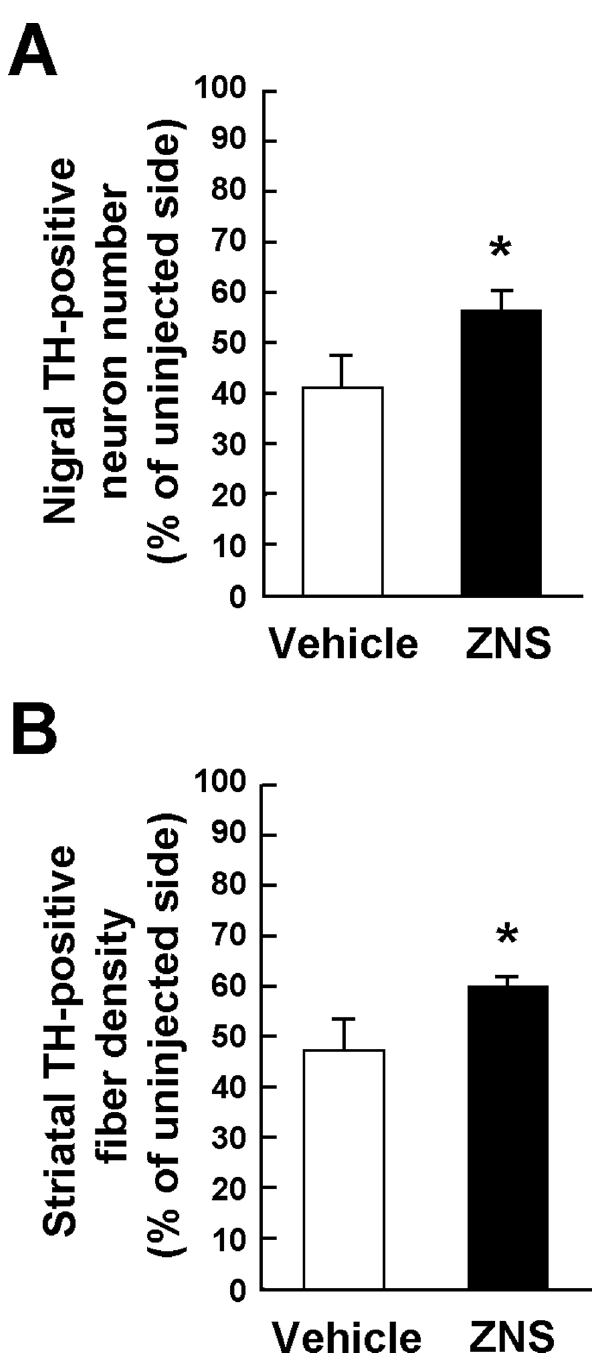
Figure 5. Effects of late treatment with ZNS on A53T a - synuclein-induced loss of nigrostriatal neurons. ZNS administra- tion was started 7 days after rAAV-A53T a -synuclein injection, and the treatment was performed until 4 weeks after viral injection. Sections were immunostained with antibody for TH. Graphs show the quantitative analysis of the number of TH-positive nigral neurons ( A ) and the semiquantitative analysis of the optical density of TH-positive striatal fibers ( B ). As compared with vehicle treatment, ZNS significantly suppressed loss of TH-positive nigral neurons ( P =0.012). Decreased densities of TH-positive nigral fibers were significantly suppressed in the ZNS group ( P =0.020). Data represent the mean 6 SD. P -values were estimated by unpaired t test (* P ,